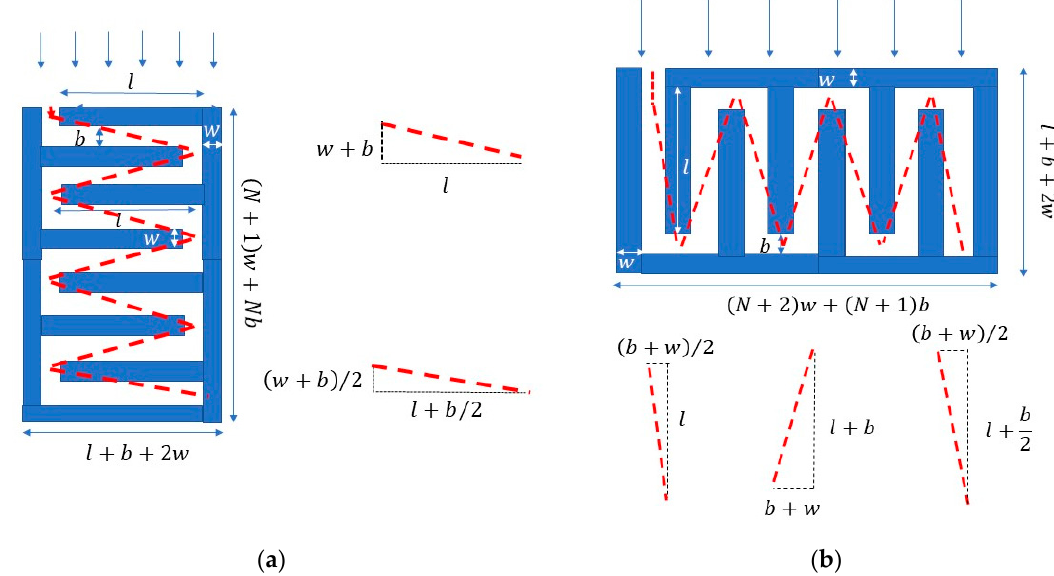
Figure 1. ( a ) Unit cells containing a single labyrinthine slit, formed by walls either ( a ) parallel to or ( b ) normal to the insonfied surface, detailing the associated dimensions, zigzag approximations to streamline paths (broken lines) and path lengths.